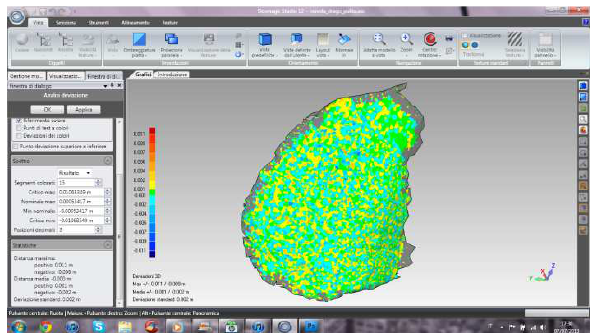
Figure 8. The deviations points-model (from the VIVID 300 scans) for the wing of the dragon